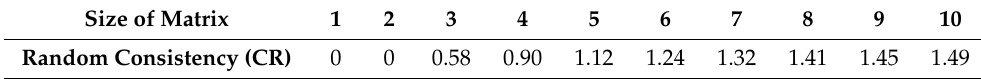
Table 3. Values of the random consistency (CR) according to the order of the matrix (Saaty’s CR values). Size of Matrix